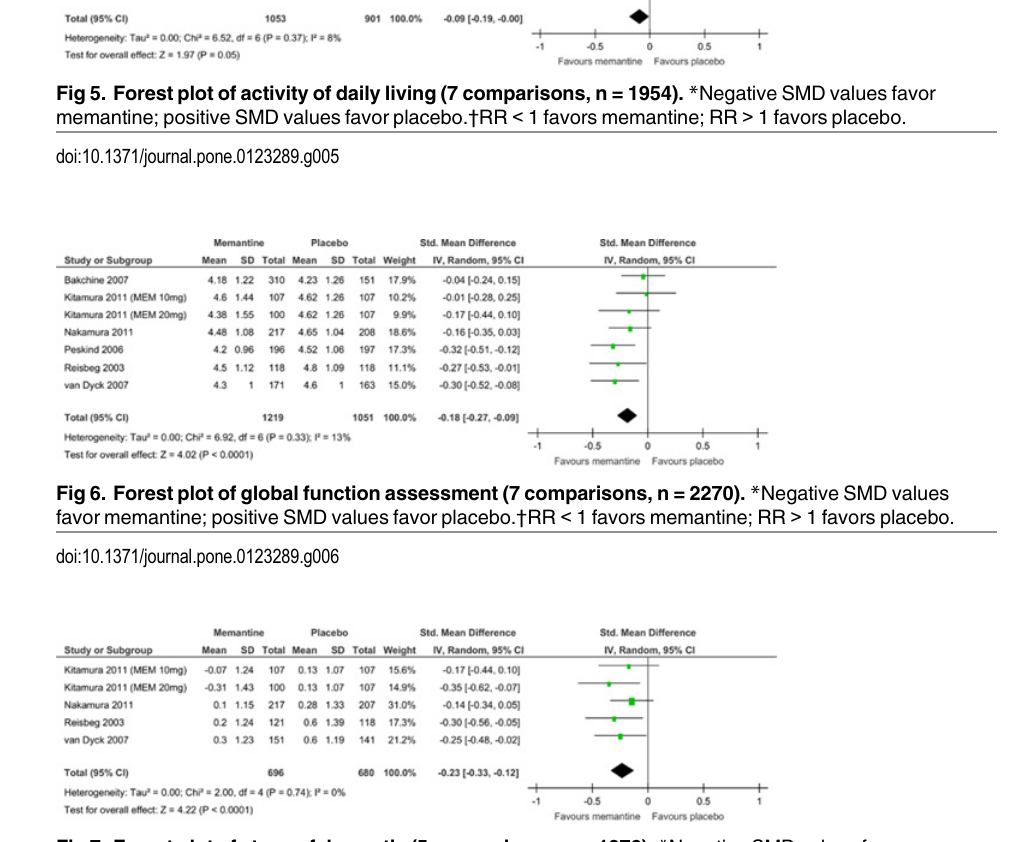
Fig 7. Forest plot of stage of dementia (5 comparisons, n = 1376). * Negative SMD values favor memantine; positive SMD values favor placebo. † RR < 1 favors memantine; RR > 1 favors placebo.